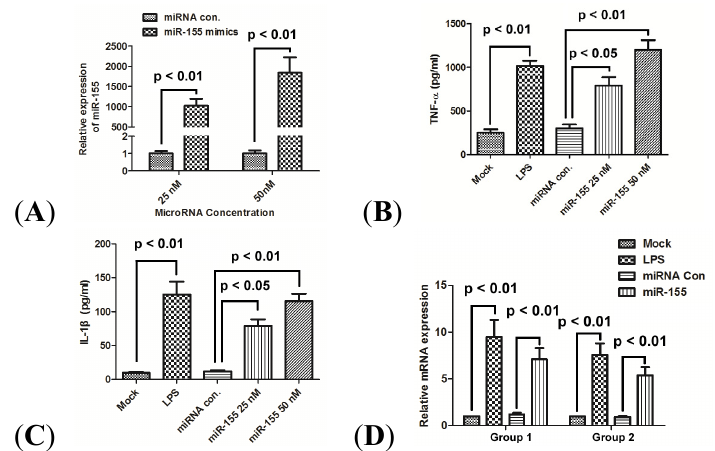
Figure 2. miR-155 promotes production of TNF- α and IL-1 β in human PBMCs. ( A ) Fold changes of miR-155 expression were determined by qRT-PCR after the transfection of miR-control, or miR-155 mimics at 25 or 50 nM for 24 h; ( B ) and ( C ) Expression of TNF- α and IL-1 β in supernatant of PBMCs 24 h post LPS treatment, or 24 h post transfection with 25 nM miR-155 mimics, 50 nM miR-155 mimics or 50 nM miRNA control. Results were expressed as pg/mL by an ELISA test; and ( D ) mRNA expression of TNF- α (group 1) and IL-1 β (group 2) in PBMCs 24 h after LPS treatment or 24 h post transfection with 25 nM miR-155 mimics, 50 nM miR-155 mimics or 50 nM miRNA control. All results are the average of three independent experiments. Statistical significance is shown.